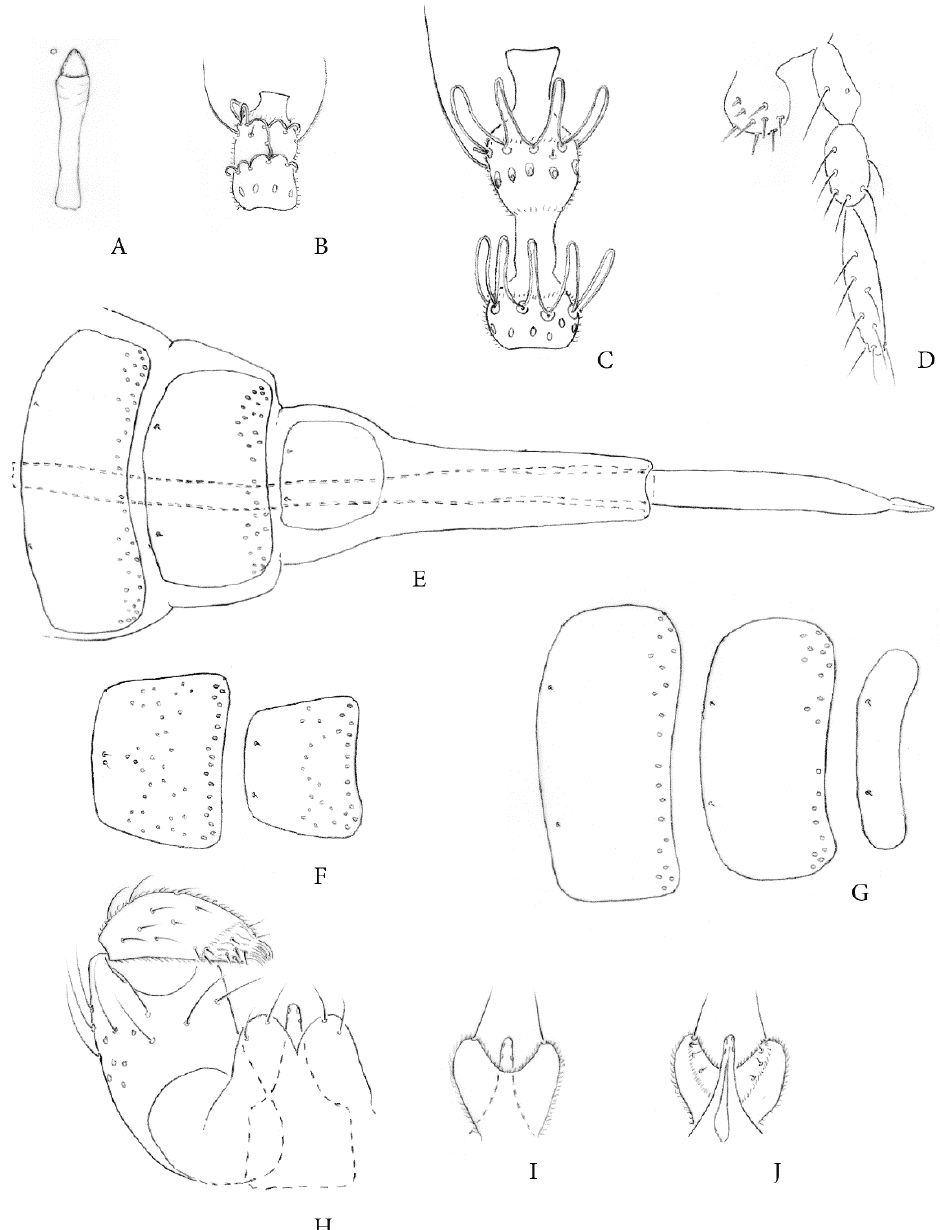
Figure 1. Stenodiplosis tectori. ( A ), Third instar spatula and associated papillae. ( B ), Female fourth flagellomere (lateral). ( C ), Male fourth flagellomere (dorsal). ( D ), Labellum and palpus. ( E ), Female abdomen, sixth segment to cerci (dorsal). ( F ), Male seventh and eighth sternites. ( G ), Male sixth to eighth tergites. ( H ), Male terminalia, one gonopod removed (dorsal). ( I ), Hypoproct and aedeagus (dorsal). ( J ), Same (ventral).